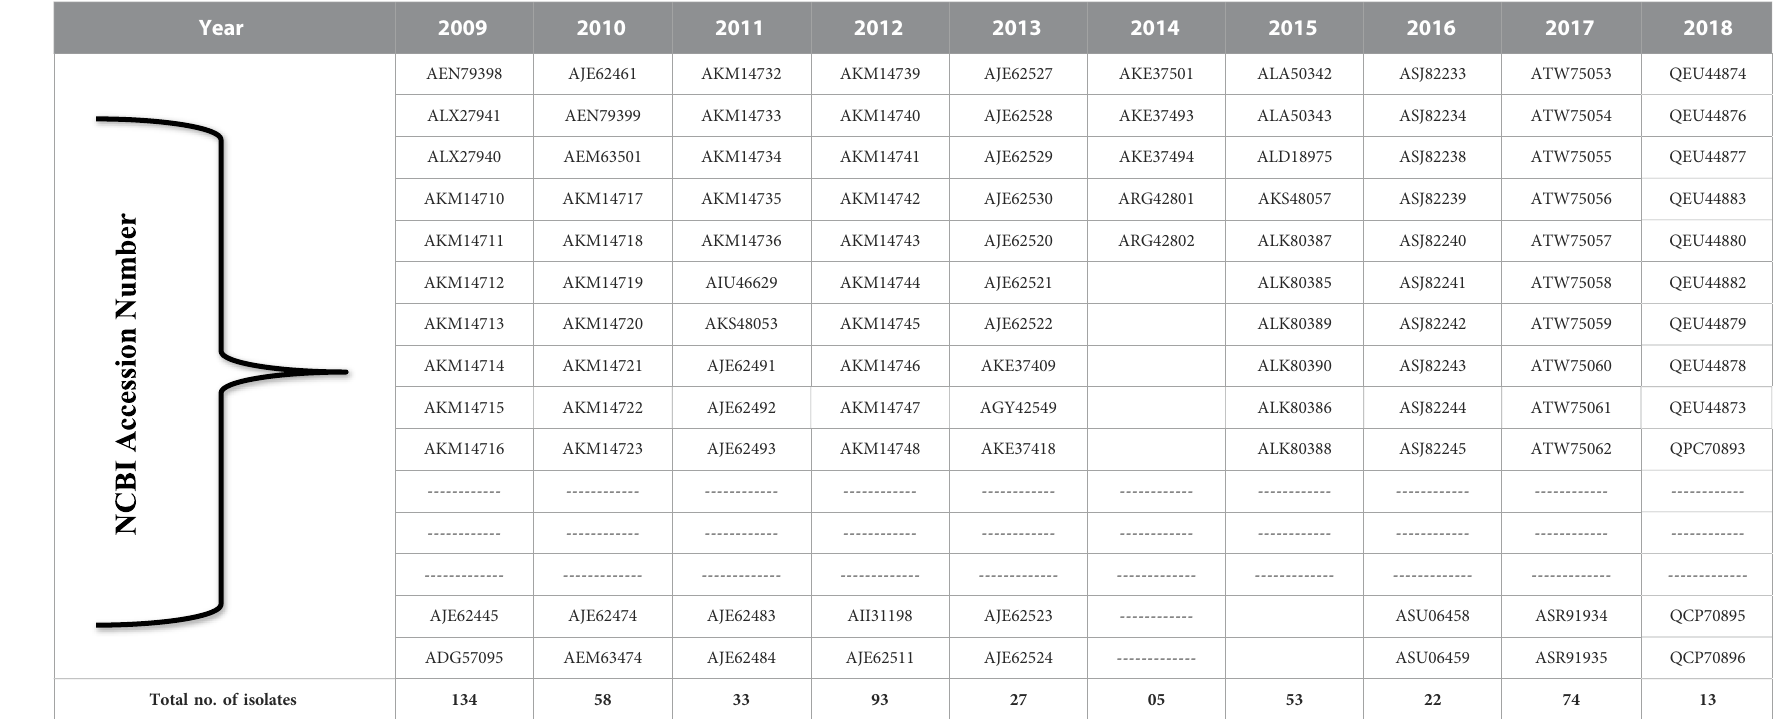
TABLE 1 NCBI accession numbers of the HA Ind strains of the in fl uenza A (H1N1) virus reported during 2009 –